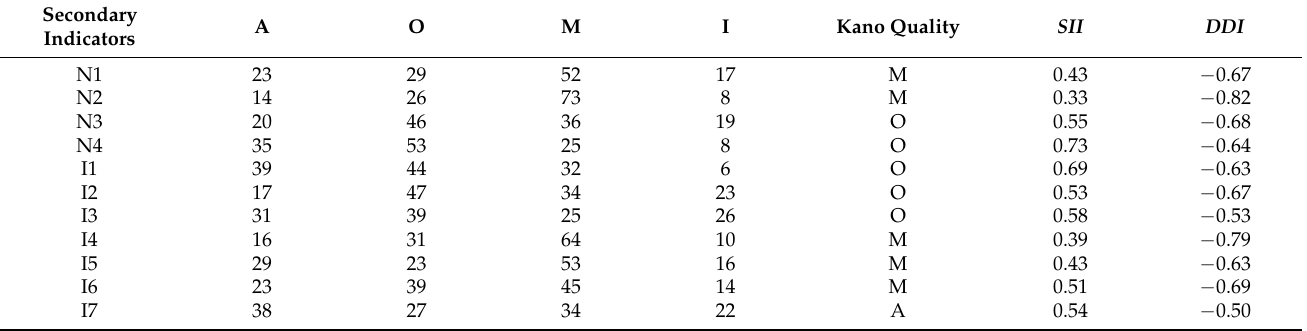
Table 4. Attribute classification of Kano indicators and calculated values of SII and DDI for each